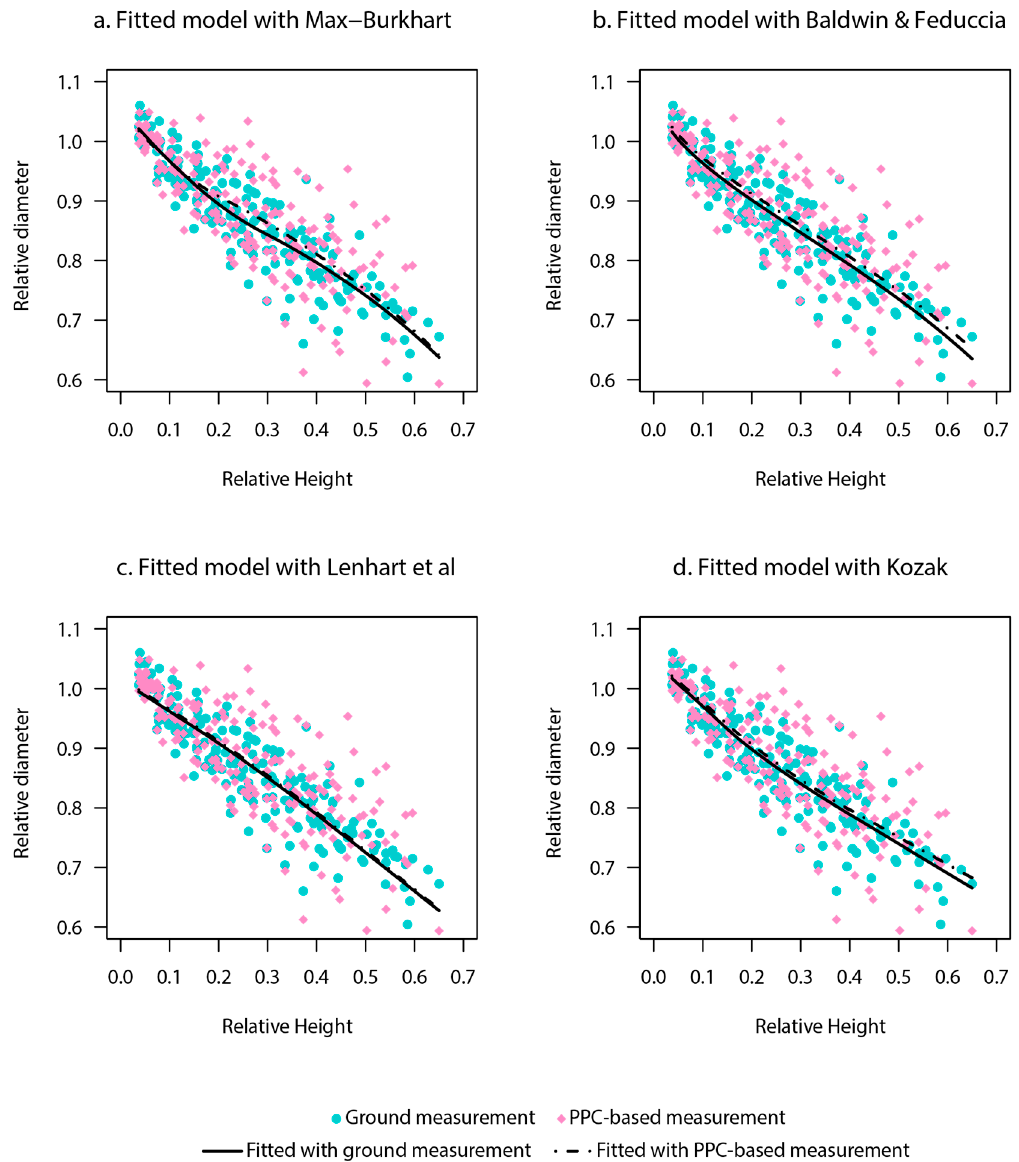
Figure 7. Comparisons of the models developed with the PPC-based measurement and the ground-based measurement. ( a ) Max and Burkhart ( b ) Baldwin and Feduccia ( c ) Lenhart et al. ( d ) Kozak.